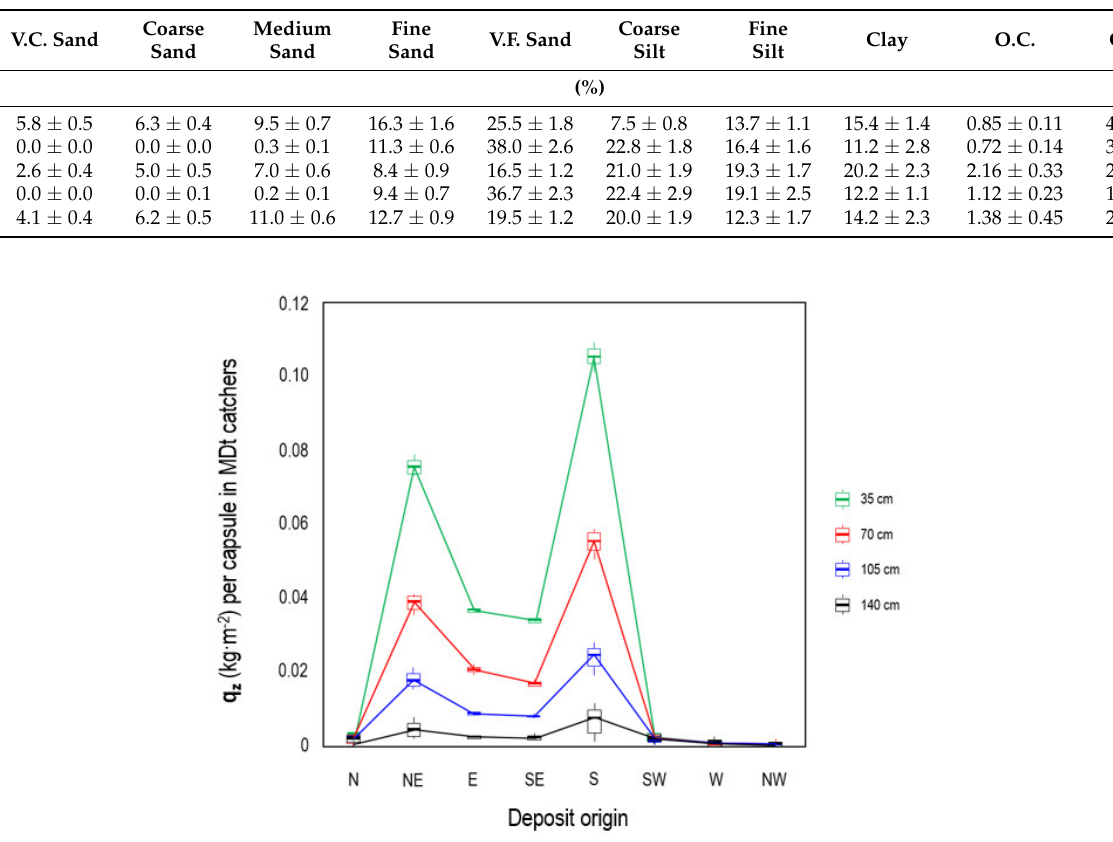
Figure 6. Hourly distribution of sediment flow monitored with load cells.